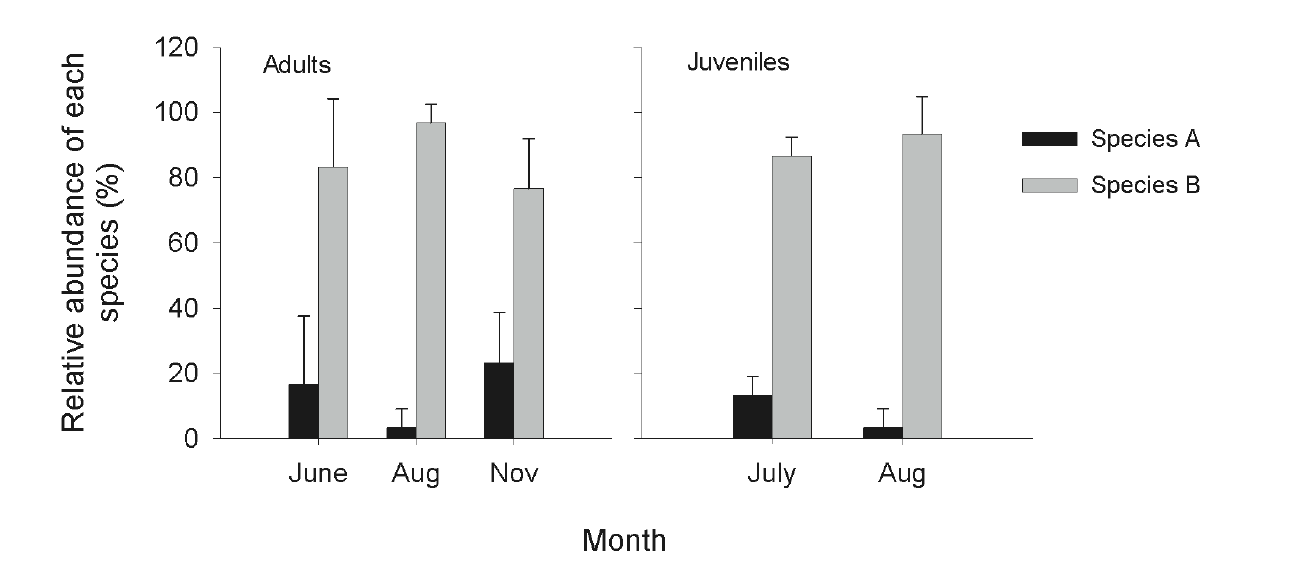
Figure 5. Monthly relative abundance of species A and B for the community of adults based on genotyping 30 individuals for each